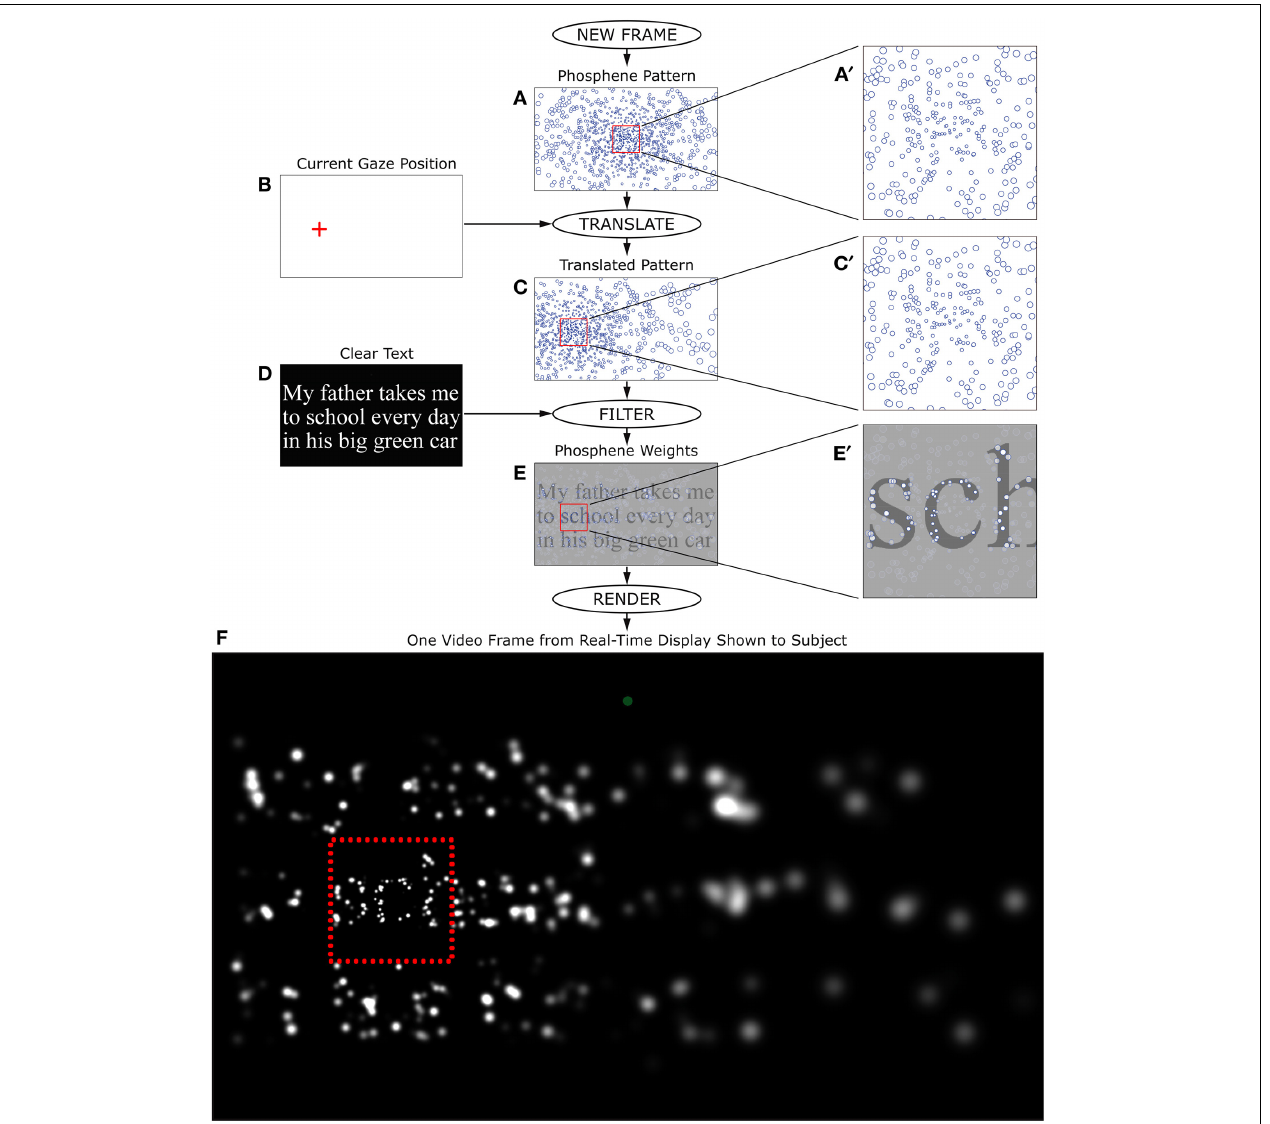
FIGURE 4 | Real-time stimulus generation. Each frame during the Reading Phase of phosphene vision trials was generated in real time according to the flow chart shown here. The phosphene pattern selected for the trial (A) , was translated in visual space so that the location (0, 0) was centered on the instantaneously read gaze position relative to the screen (B) , to generate a pattern relative to the point of regard (C) . The text for the given trial was then rendered as an off-screen image (D) , and the translated pattern of locations overlaid on that image as a set of independent averaging filters. Each phosphene brightness was determined by taking the local average luminance of the text image weighted by a two-dimensional Gaussian filter that was sized according to the eccentricity of the phosphene (see main text). The